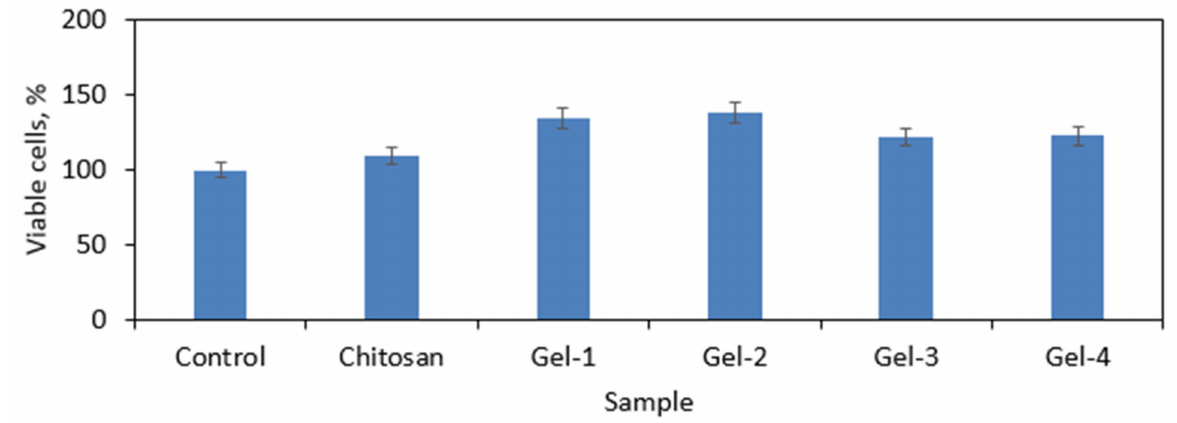
Figure 18. Cytotoxicity study performed using (2,3-Bis-(2-Methoxy-4-Nitro-5-Sulfophenyl)-2H-Tetrazolium-5- Carboxanilide) (XTT) assay.